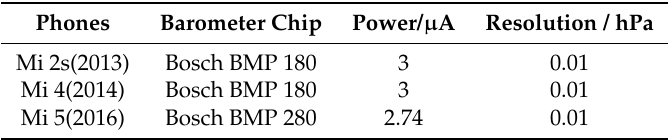
Table 2. The detail of